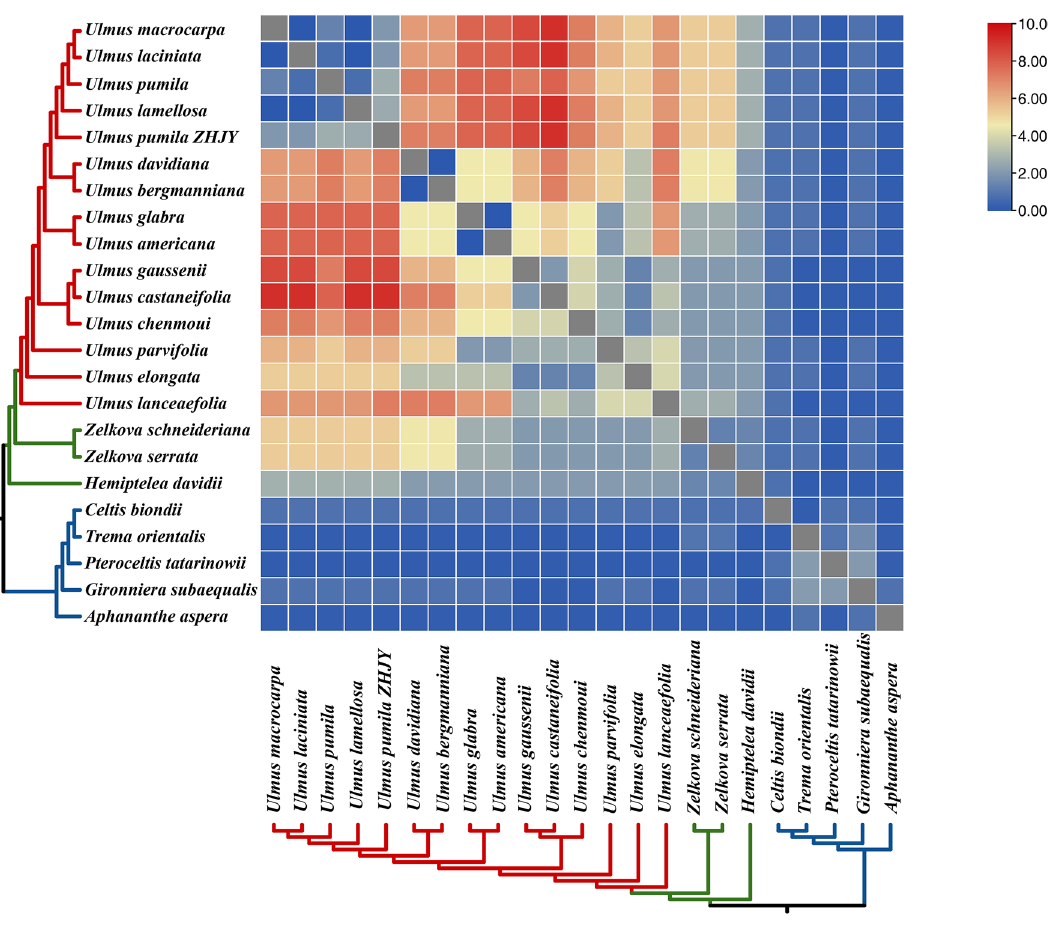
Figure 6. Pairwise Ka/Ks ratios in Ulmus and other Ulmaceae